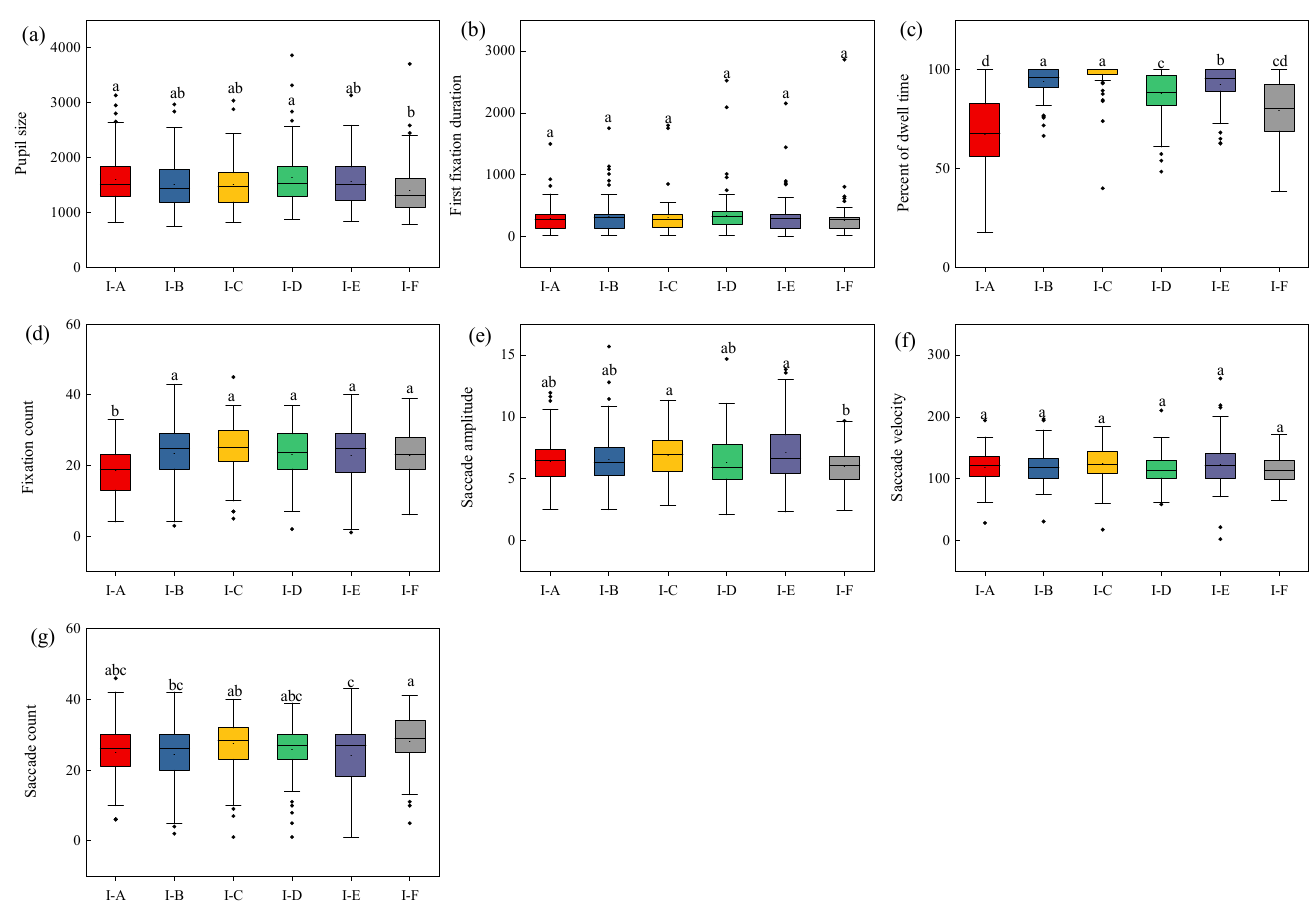
Figure 3. The eye-tracking measures of vegetation type are shown; ( a – g ) represent pupil size, first fixation duration, the percentage of dwell time, fixation count, saccade amplitude, saccade velocity, and saccade count, respectively; I-A–I-F represent grassland, shrub, broad-leaf tree, coniferous tree, bamboo, and palm, respectively. Different lowercase letters indicate significant differences among different attributes with the same category ( p < 0.05). Little square represents the mean and rhombus filled with black represents outliers.